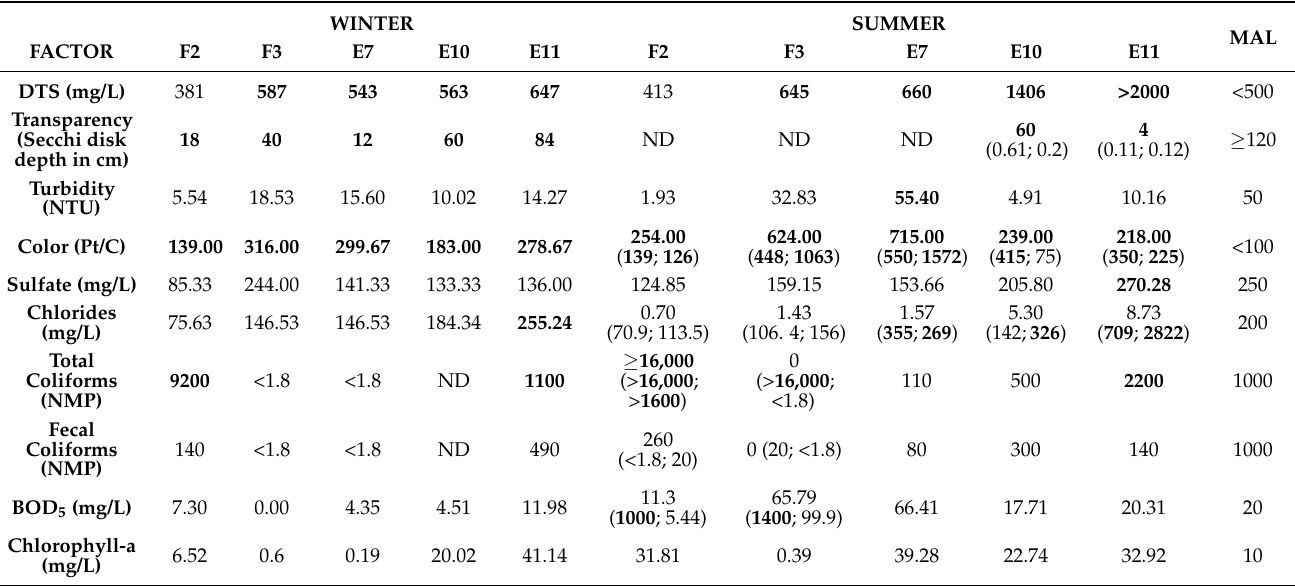
Table 2. Water quality factors in all sampled stations during winter and summer. All bold numbers are values that exceed the maximum allowed limit (MAL). The values in brackets are the results previously reported by Rivera et al.